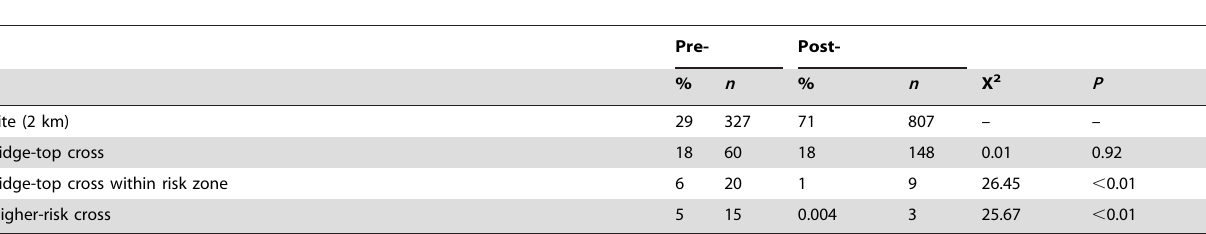
Table 1. Percent of all golden eagles observed in the study site (within 2 km from turbine string) that were: over the ridge-top area (within 100 m from turbine string); within the risk zone ( # 150 m above ground); and, within the risk zone at winds above turbine cut-in speed (higher-risk flight; 6.8 km/h) at the Dokie 1 Wind Energy Project site between 30 September–24 October in pre- (2009) and post-construction (2010–2011) years.